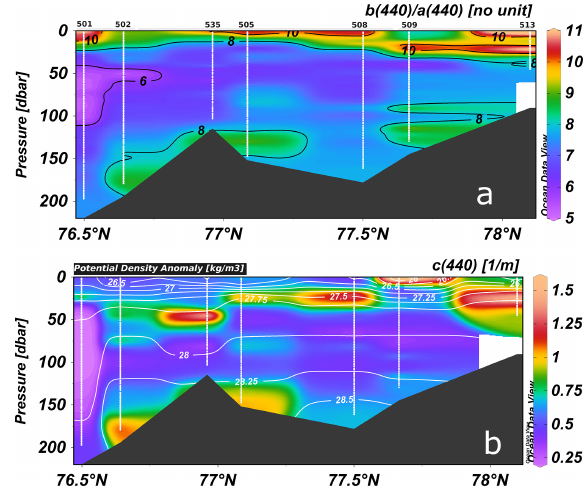
Figure 5. Section plots of (a) ratio of scattering to absorption at 440nm and (b) total attenuation coefficient at 440nm with white contours of potential density anomaly from in situ ac-s data for the south–north transect (see Fig. 1). Plots are made with Ocean Data View (Schlitzer, Reiner, Ocean Data View, https://odv.awi.de/, last access: 30 January